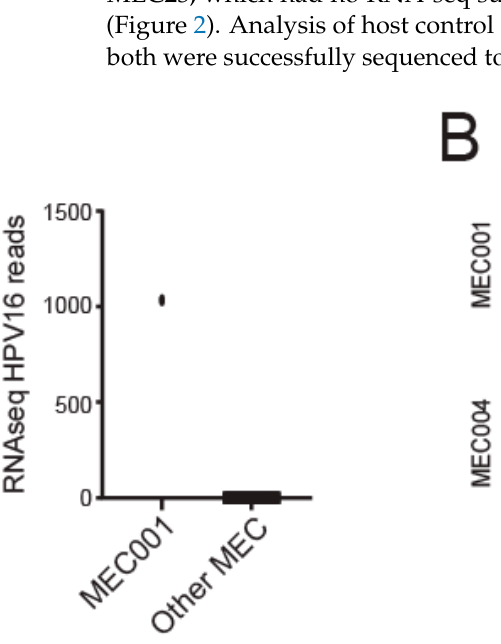
Figure 1. Analysis of HPV type distribution in our MEC cohort. ( A ) Number of RNA-seq HPV16 reads for MEC1 and other MECs. ( B ) p16 immunohistochemistry performed on sections from the HPV16+ tumor (MEC1) and a representative HPV negative tumor (MEC4).